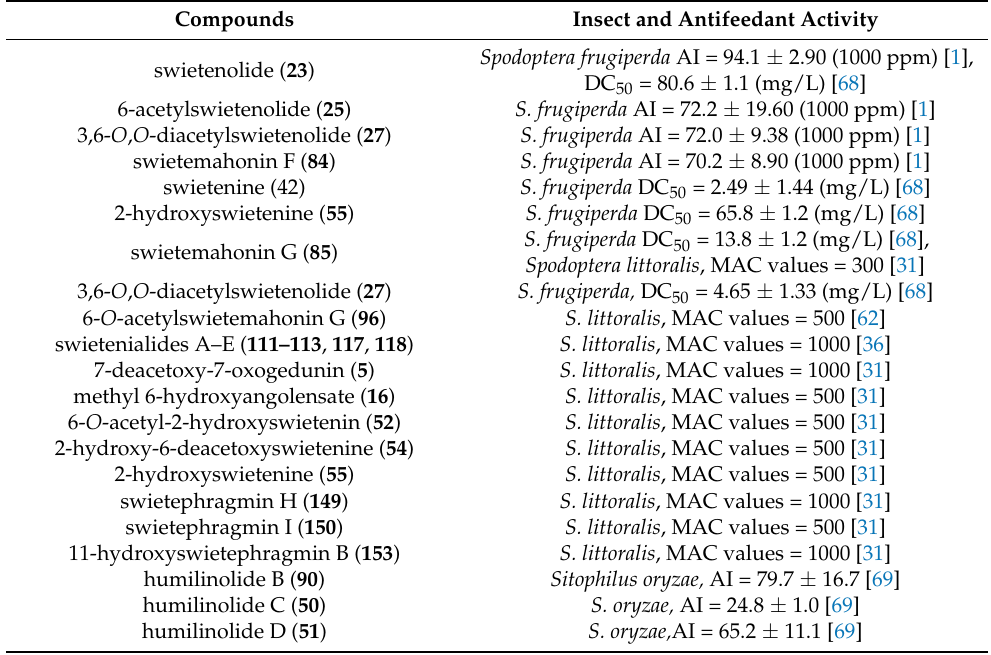
Table 6. Antifeedant effects of